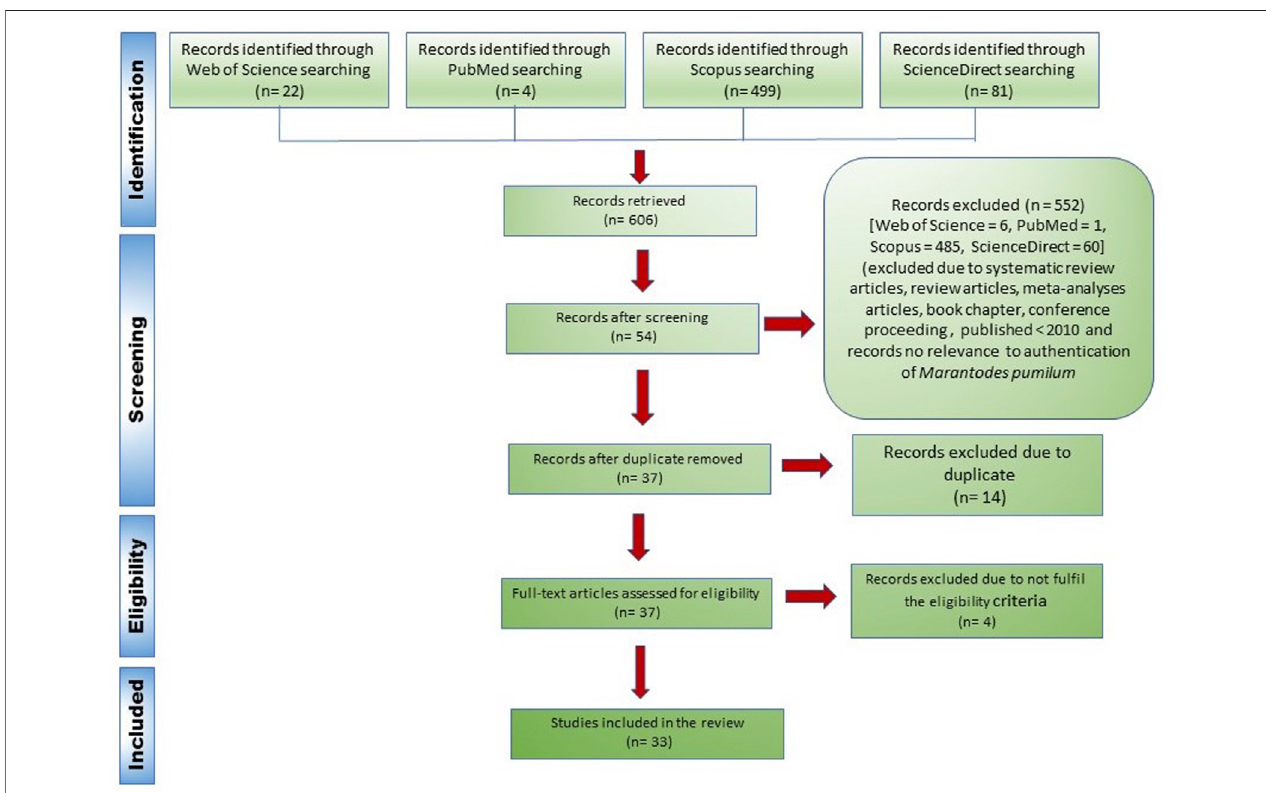
FIGURE 2 | Flowchart of the article search process according to the PRISMA guidelines (Moher et al., 2009).